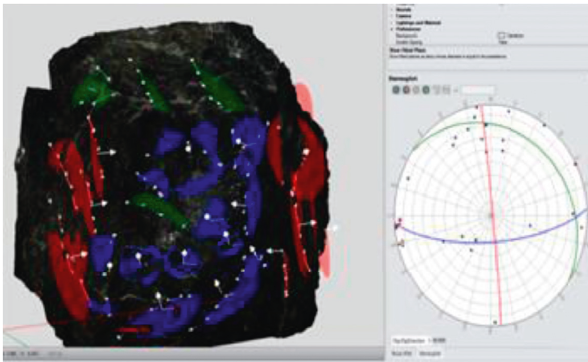
Figure 5: Structural plane information analysis groups.